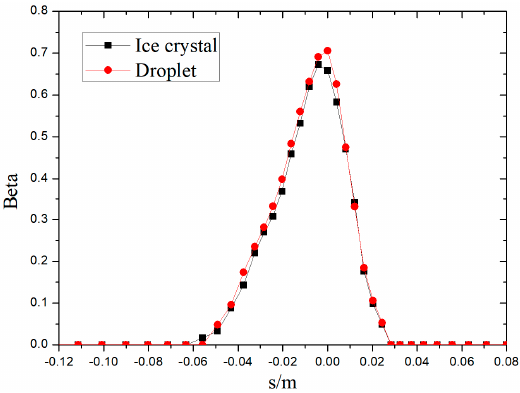
Figure 9. Calculation results of ice crystal and droplet collection coe ffi cients.